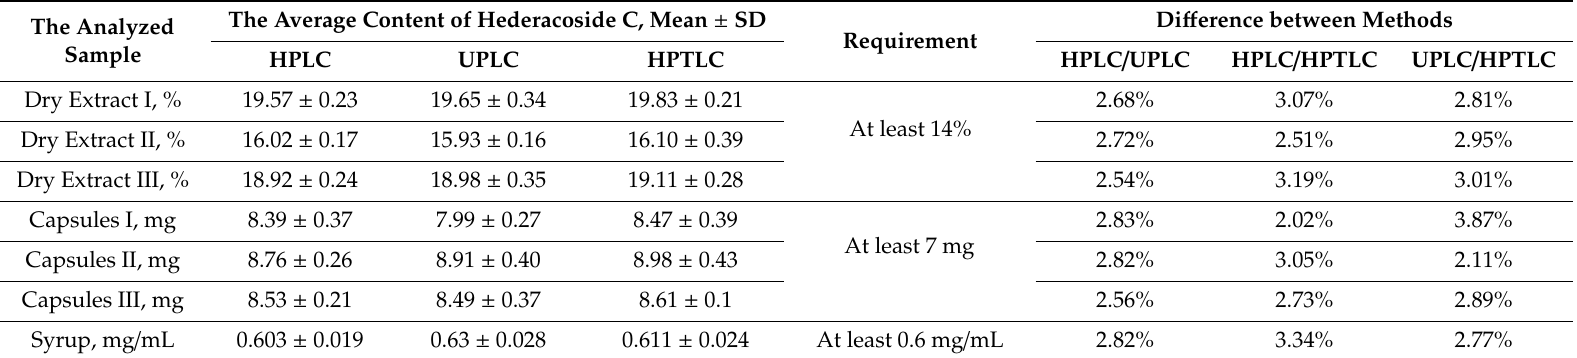
Table 1. Content of hederacoside C in all samples and di ff erence between